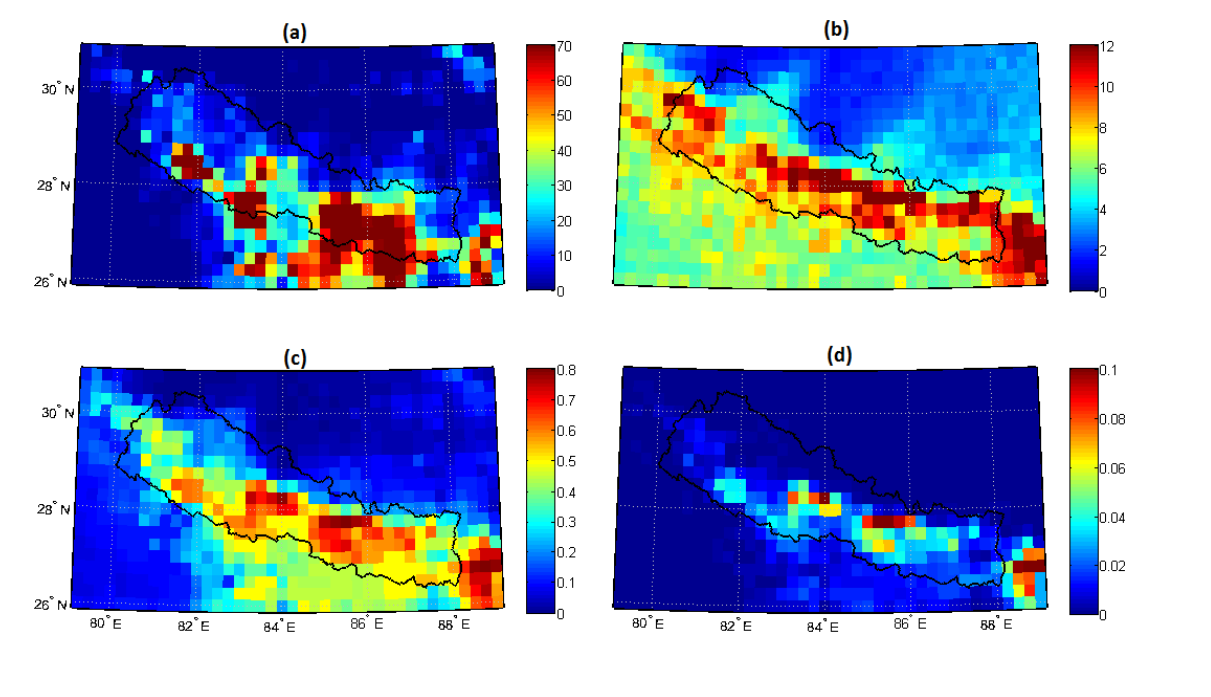
Figure 7. Example maps of regional precipitation for 2 September 2013: ( a ) 3B42RT amount (mm); ( b ) climatological mean (mm); ( c ) probability of precipitation > 10 mm based on combined climatology + satellite model; ( d ) probability of precipitation > 50 mm.